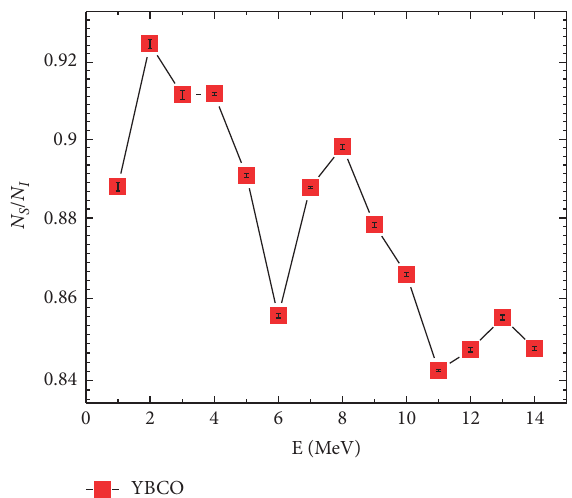
Figure 7: N s / N I caused by PKAs for different neutron